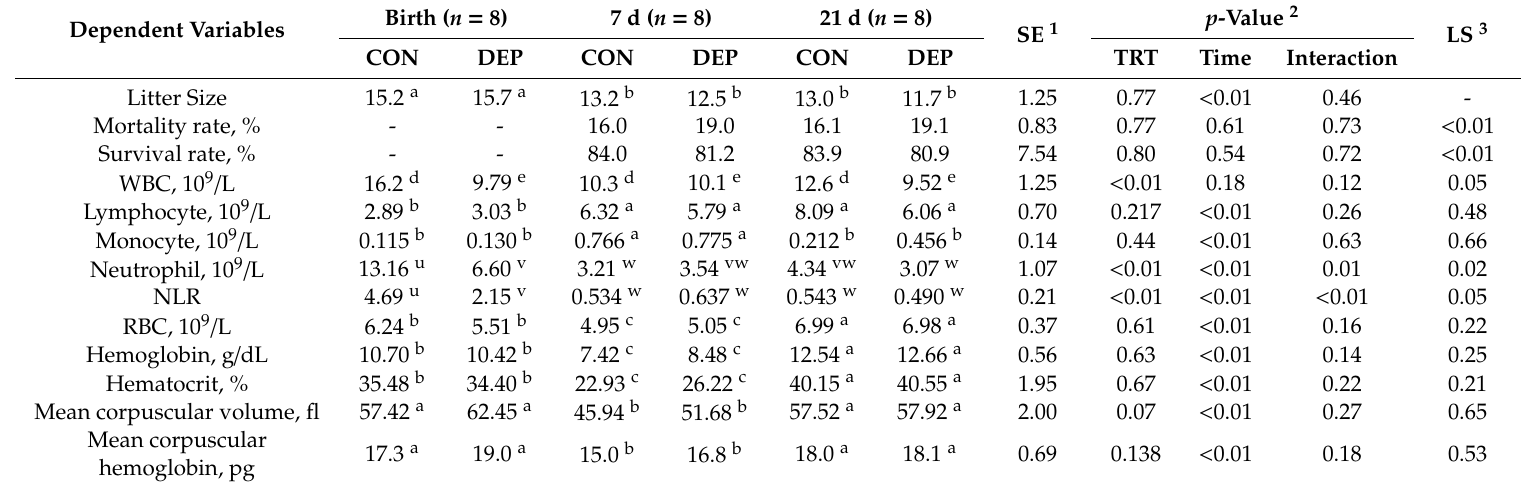
Table 5. Survival rate and complete blood cell count in piglets with (CON) or without (DEP) access to maternal feces at birth, 7, and 21 d of age. Dependent